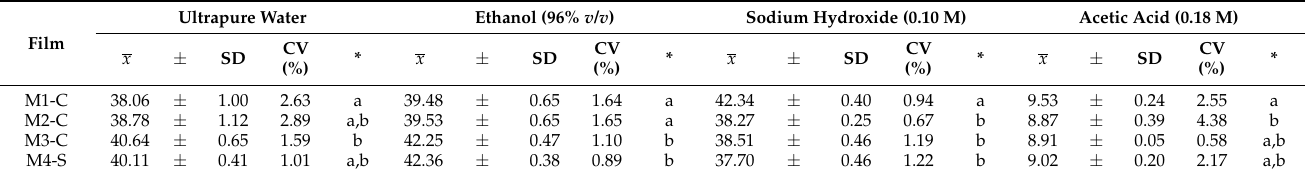
Table 5. Film solubility.